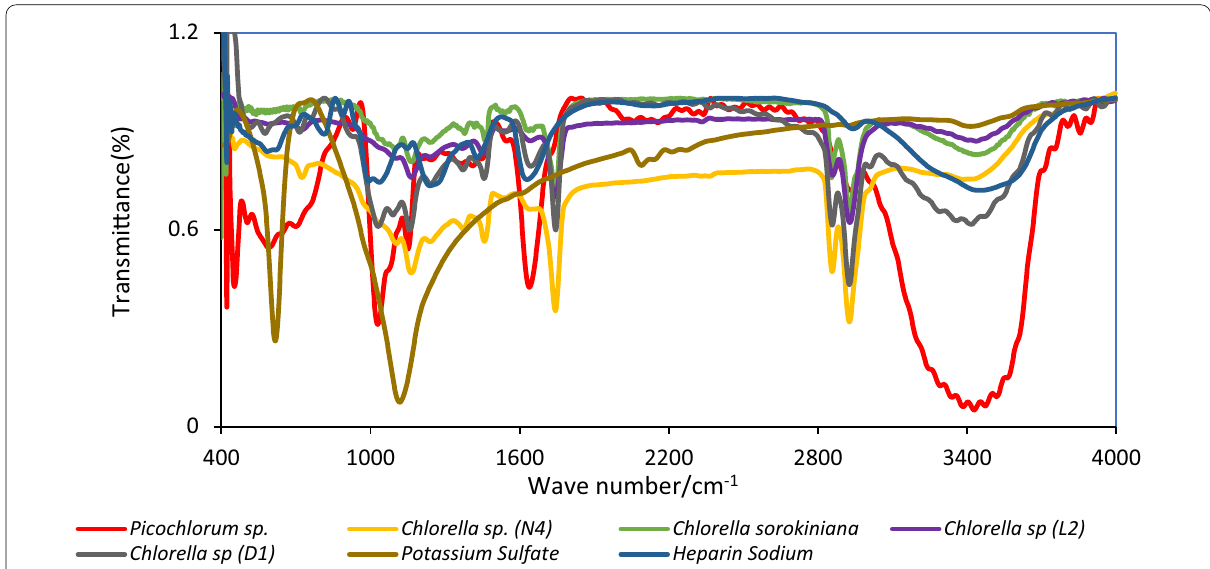
Fig. 5 FT-IR spectra of sPS extracted by comparing heparin and potassium sulfate as standard between 400 and 4000 cm −